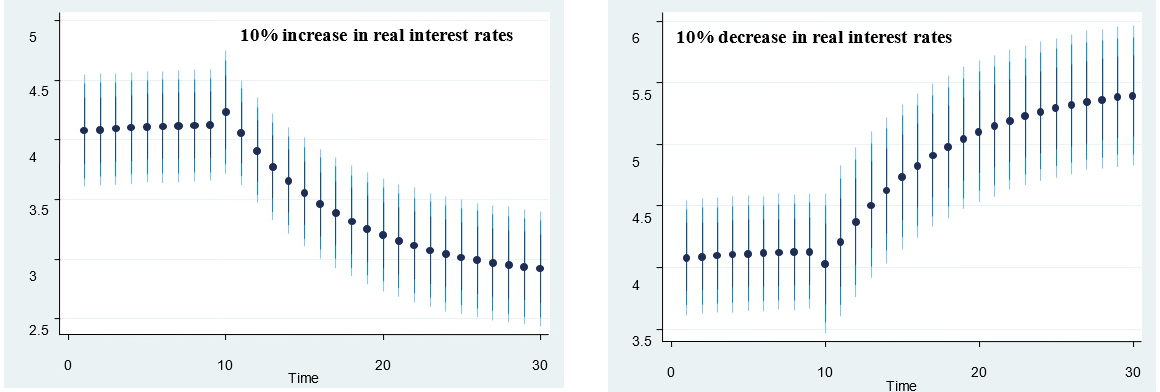
Figure 6. Real interest rate and domestic investment. The above graphs portray ±10% in the real interest rate and its impact on domestic investment. The dots depict the average prediction value, while the dark blue to light blue lines indicate 75%, 90%, and 95% confidence interval, respectively.